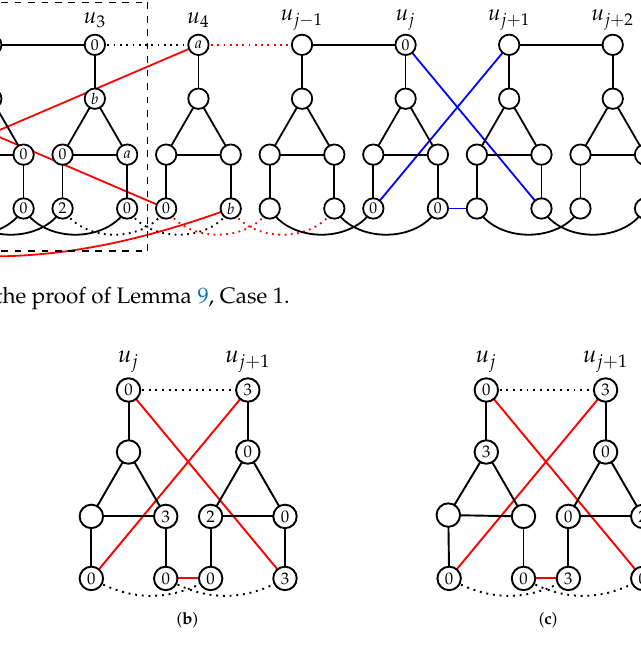
Figure 9. The DRDF’s for three subcases of Case 1 in Lemma 9.